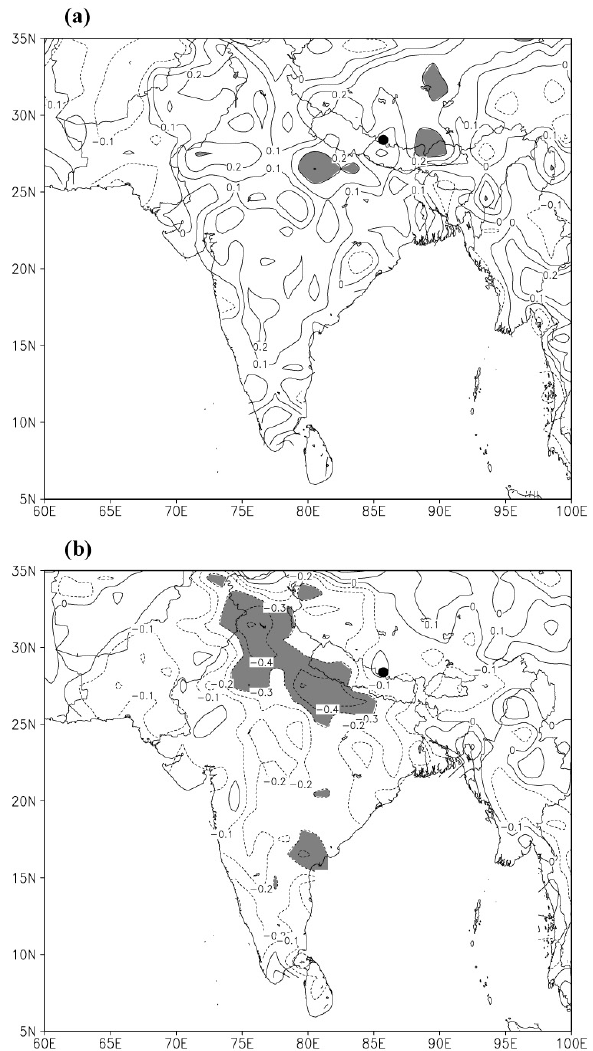
Fig. 6. Correlation coefficients of the DSP accumulation rate vs. summer monsoon season precipitation (a) and the DSP δ 18 O record vs. the monsoonal precipitation (b) over the period of 1951–1996. Grey shading indicates correlation significance at 95% confidence level. The filled black circle indicates the DSP core drilling site. Summer monsoon precipitation data are from the GPCC monthly precipitation data set from 1951–present with 1.0 ◦ × 1.0 ◦ resolution (available at